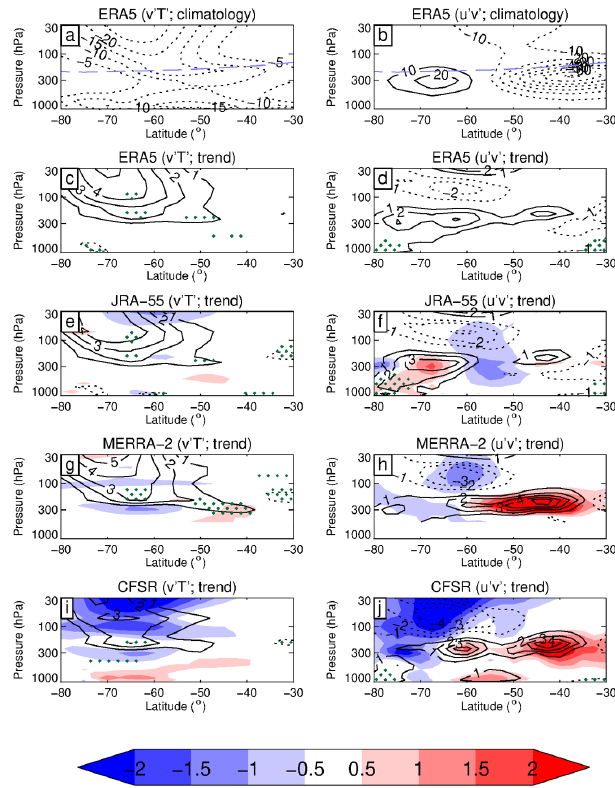
Figure 5. November trend of eddy heat flux v (cid:48) T (cid:48) (contour units: ± 1.0, ± 2.0, ± 3.0, ± 4.0, and ± 5.0ms − 1 K per decade; left column) and eddy momentum flux u (cid:48) v (cid:48) (contour units: ± 1.0, ± 2.0, ± 3.0, and ± 4.0m 2 s − 2 per decade; right column) from 1980 to 2001 for ERA5 (c, d) , JRA-55 (e, f) , MERRA-2 (g, h) , and CFSR (i, j) . The shading represents differences from ERA5 at intervals of ± 0.5, ± 1.0, ± 1.5, and ± 2.0. Note that results in the range 500 to 1000hPa are not included in panels (g) and (h) . Panels (a) and (b) show the climatological mean values of v (cid:48) T (cid:48) (ms − 1 K) and u (cid:48) v (cid:48) (m 2 s − 2 ) for ERA5 from 1980 to 2001, with the blue dashed line indicat- ing the climatological tropopause level. Stippling denotes regions where the trends are significant at the 5% significance